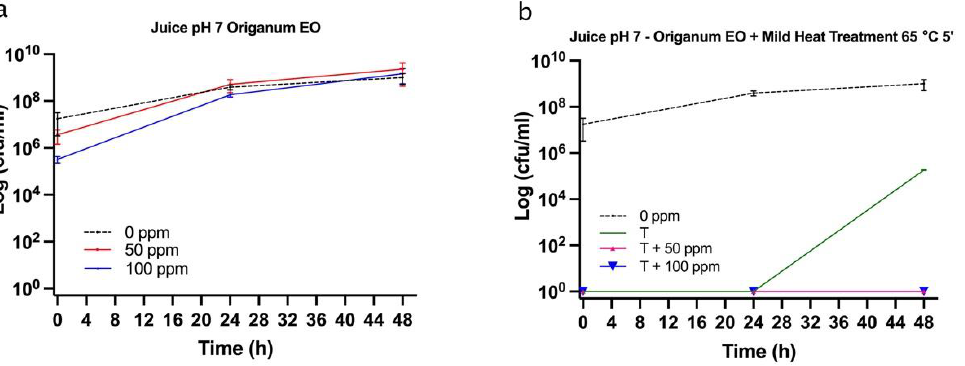
Figure 13. E. coli cell load in fruit juice pH 7 plated on MacConkey agar (Log CFU/mL). ( a ) OEO (0, 50, and 100 ppm) treatment and ( b ) thermal treatment 65 °C 5 min alone and combined with OEO (50 and 100 ppm).